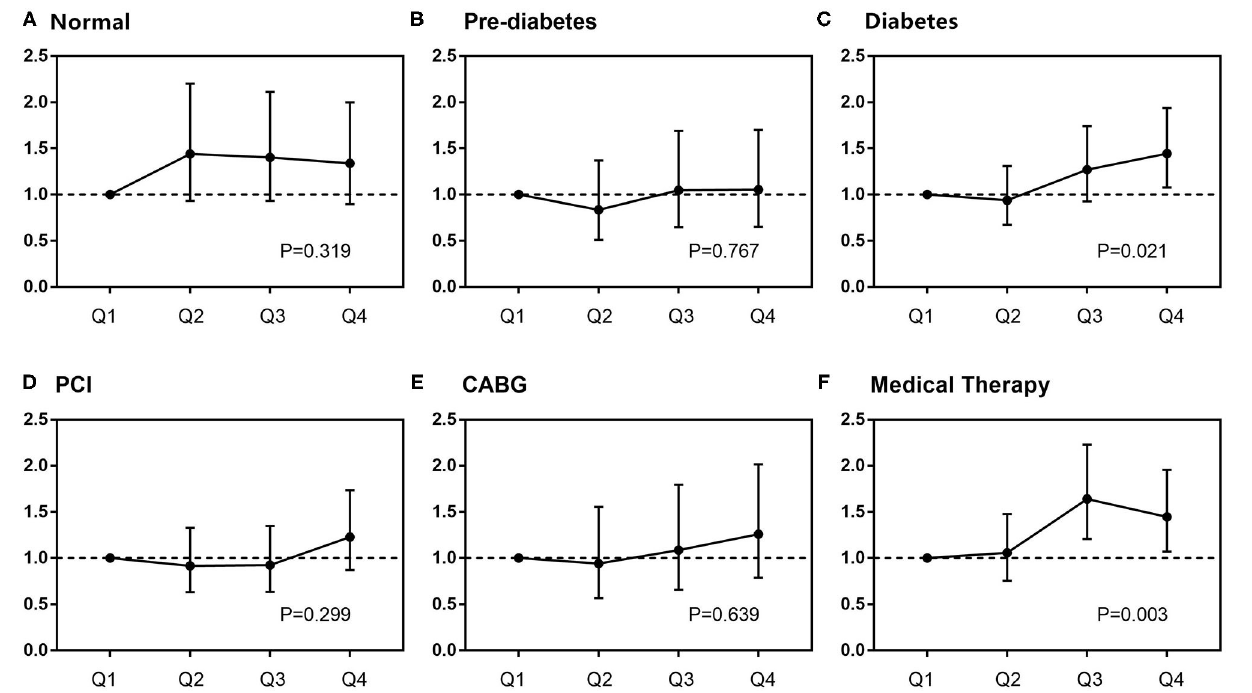
FIGURE 4 | Subgroup analysis of the relationship between DB and mortality. In different glucose metabolism statuses (A–C) , adjusted variables were SS II, treatment strategies, previous history of stroke, body mass index, blood pressure, low-density lipoprotein-cholesterol, high-sensitivity C-reactive protein, and liver enzymes. In different treatments (D–F) , adjusted variables were SS II, glucose metabolism status, previous history of stroke, body mass index, blood pressure, low-density lipoprotein-cholesterol, high-sensitivity C-reactive protein, and liver enzymes. CABG, coronary artery bypass grafting; PCI, percutaneous coronary